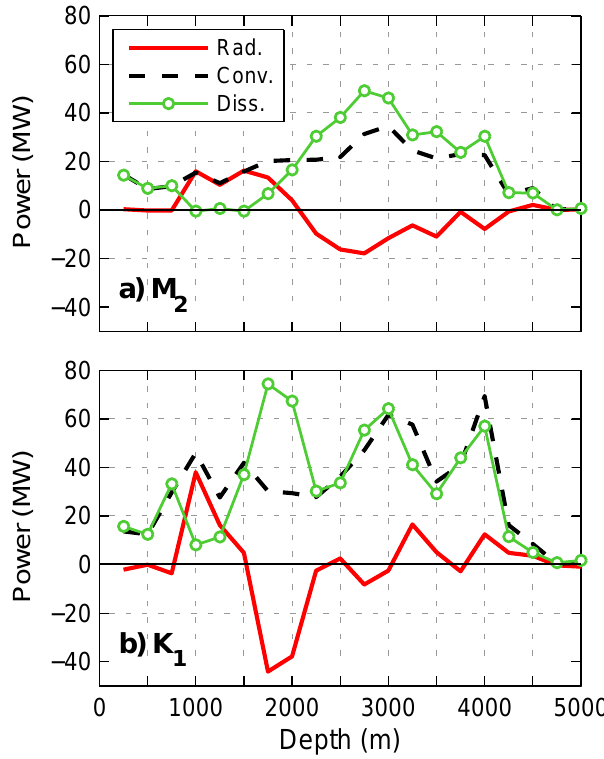
Figure 8. Total baroclinic radiation (red), conversion (dashed black), and dissipation (green, circles) for the (a) M 2 and (b) K 1 constituents, integrated in 250m isobath bounded